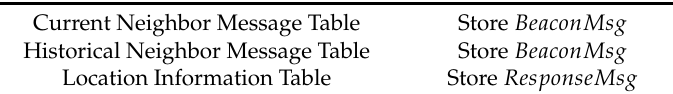
Table 1. VANET Information